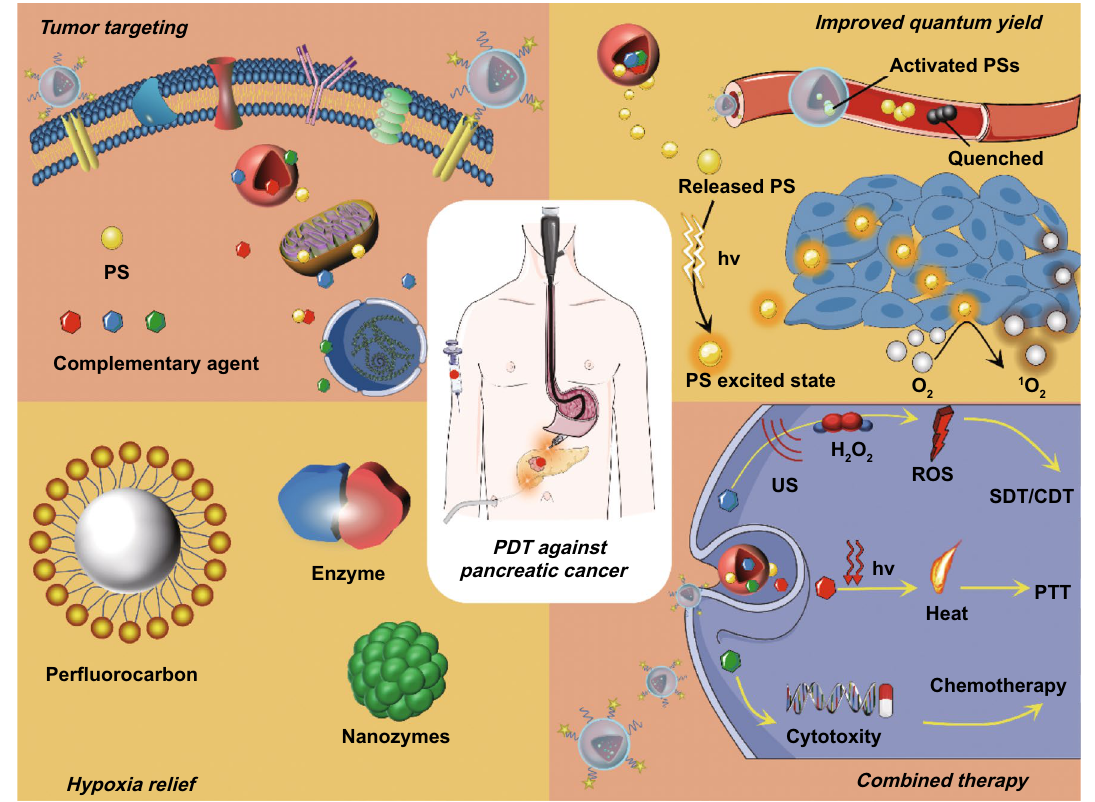
Fig. 1 Schematic illustration of PS-loaded NPs for localized photodynamic destruction of